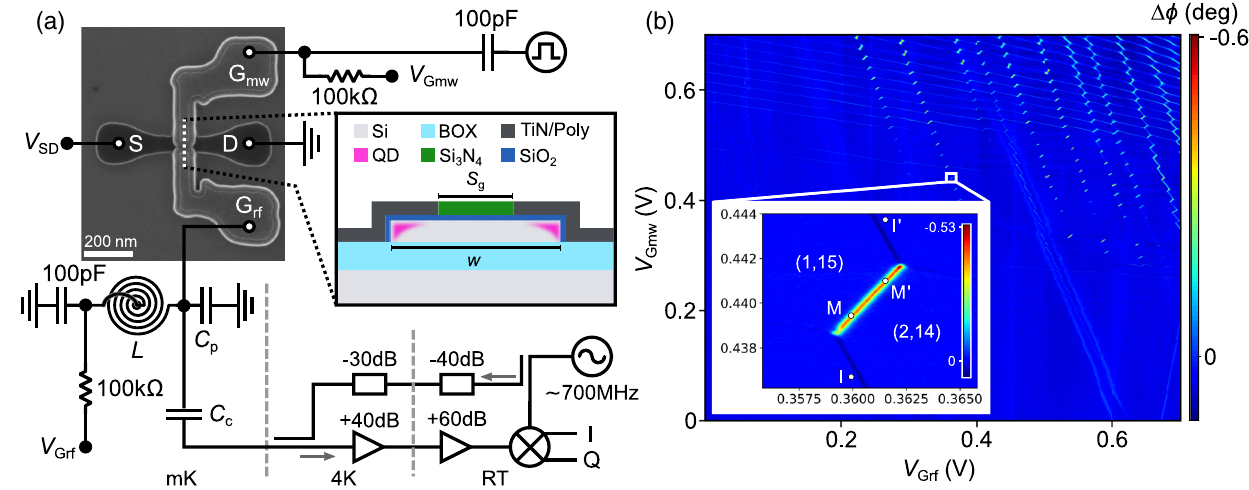
FIG. 1. Measurement setup and charge stability diagram of the DQD. (a) Scanning electron microscopy (SEM) micrograph and sketch of the transistor and measurement setup. The SEM micrograph is taken during processing, after the definition of the Si 3 N 4 spacers. The sketch inset capturing the cross section of the transistor perpendicular to the channel illustrates the architecture of the device as well as the DQD formed in parallel in the channel corners when applying a positive potential to the face-to-face top gates. Gate G to a resonant LC circuit in which the inductive component is a superconducting NbN planar spiral inductor. (b) Charge stability diagram recorded using gate-based dispersive readout while sweeping the potentials of G DQD. Counting the number of charge transitions in the diagram allows identification of the exact DQD charge configurations, e.g., that shown in the inset, which highlights the (1,15)-(2,14) interdot charge transition investigated in this paper. The points I, I 0 , M, and M 0 indicate the initialization and measurement points of pulsing experiments presented in Fig.